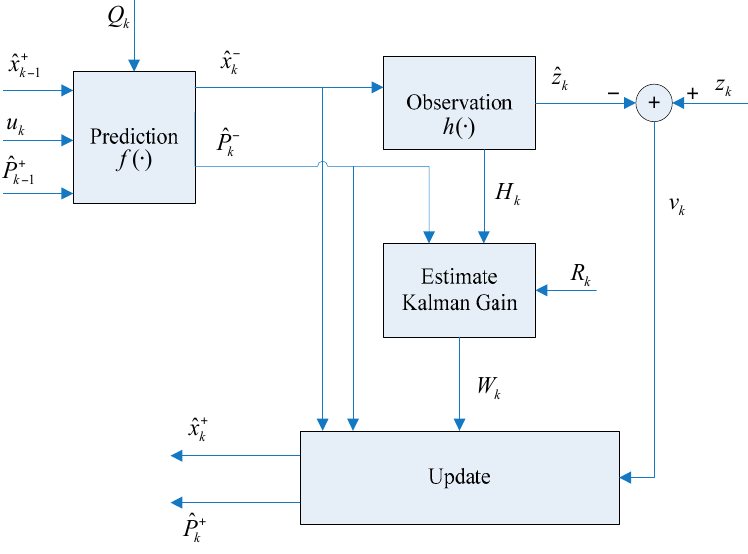
Figure 12. The architecture of the AEKF-SLAM system, as described in [50].